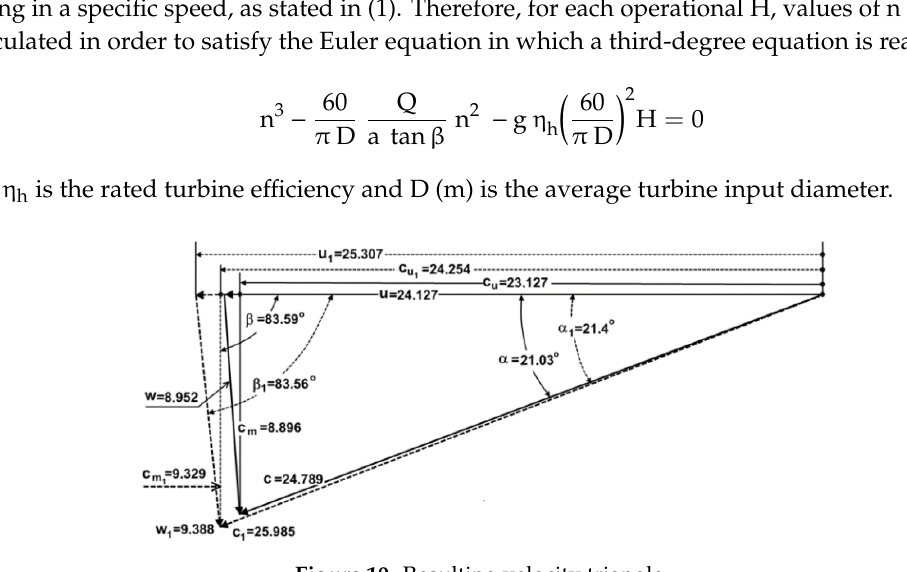
Figure 9. Velocity triangle.